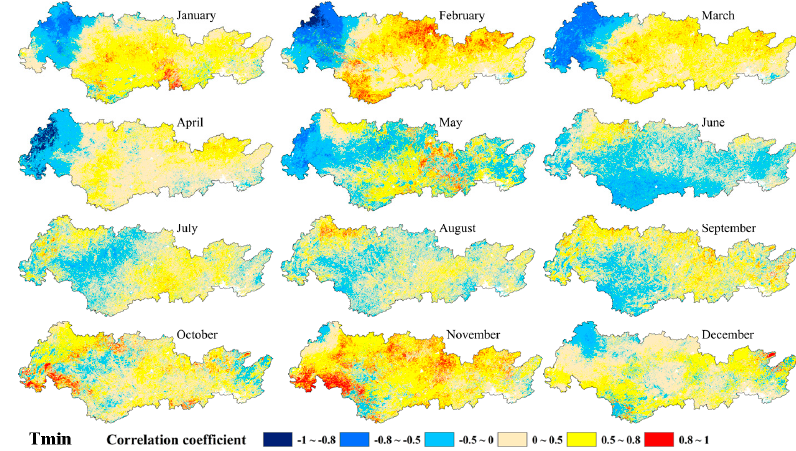
Figure 8. Spatial distribution of the correlation coefficient between ET and daily minimum temperature (T min ) in the PRB.